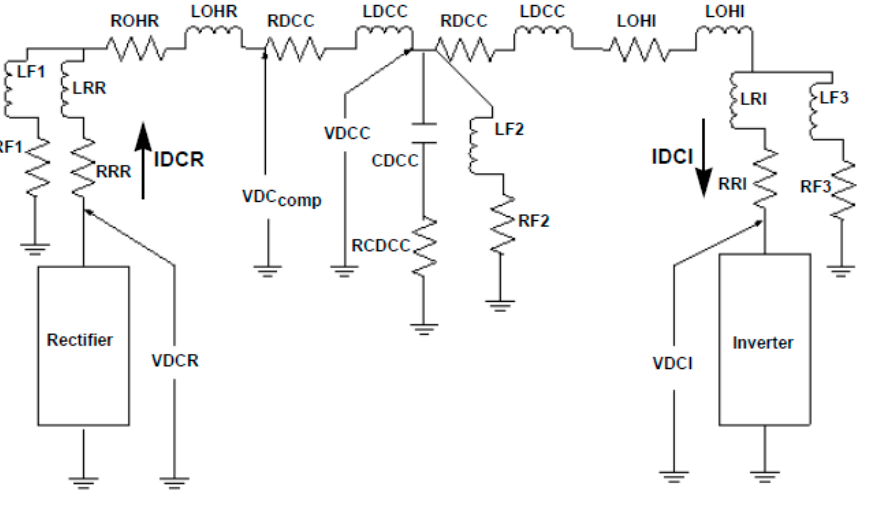
Figure 3. A DC line circuit arrangement of CDC7T [23].